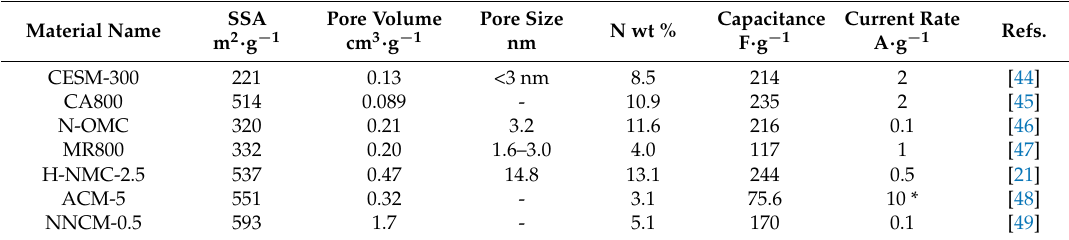
Table 3. Literature review on N-doped mesoporous carbon electrochemical performances in H 2 SO 4 electrolyte along with their specific surface area and nitrogen